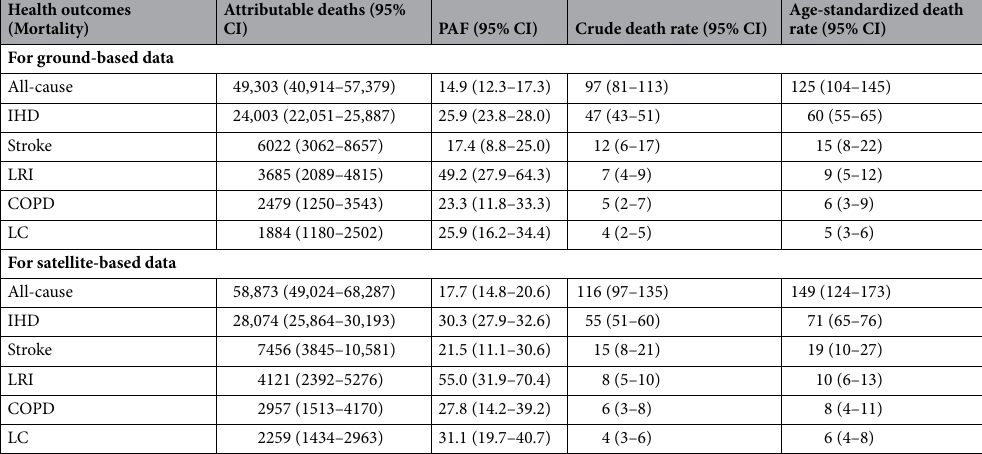
Table 1. Number of all cause and cause specific mortalities due to ambient PM 2.5 exposure in Iran